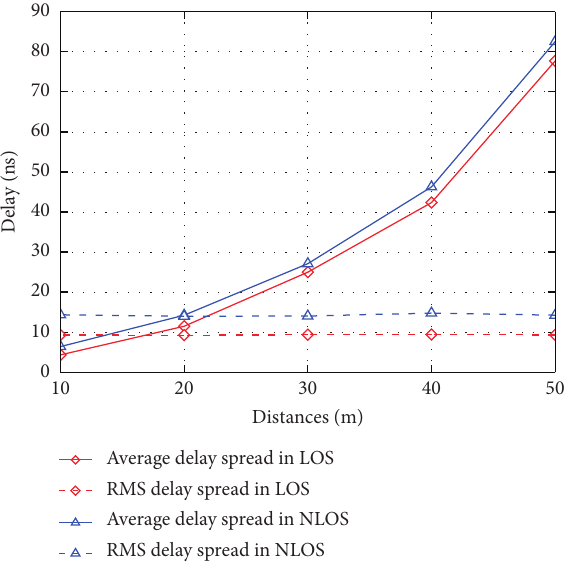
Figure 9: Delay parameters at different distances. Table 4: Determination of coefficients and